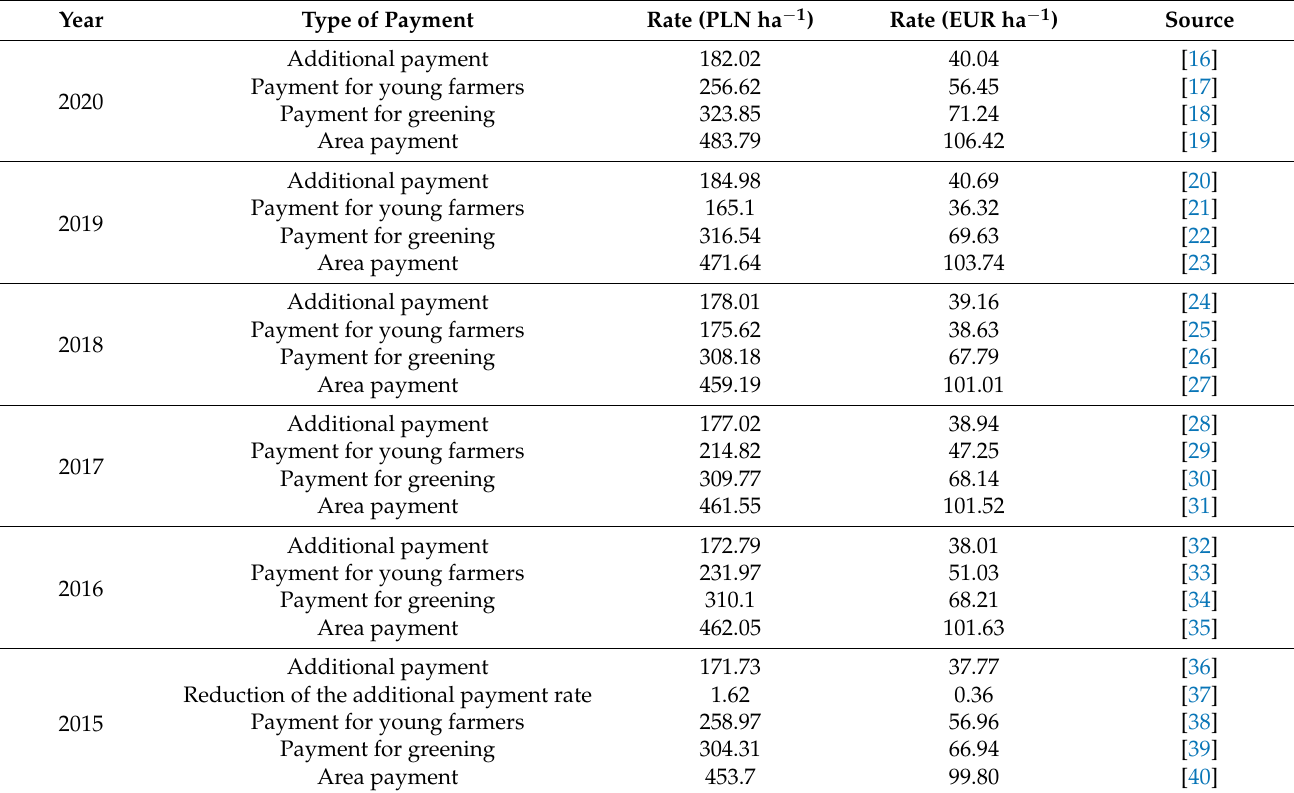
Table 2. Rates of payments for SRC production in Poland between